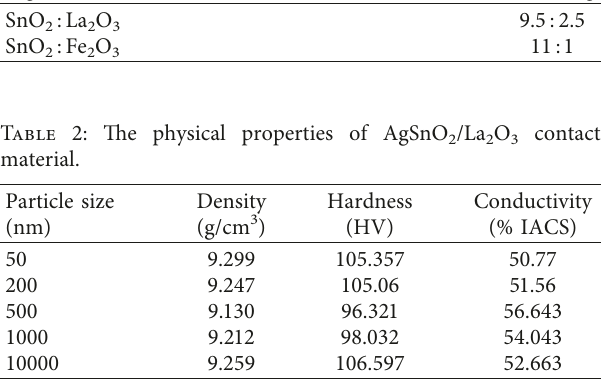
Table 3: The physical properties of AgSnO